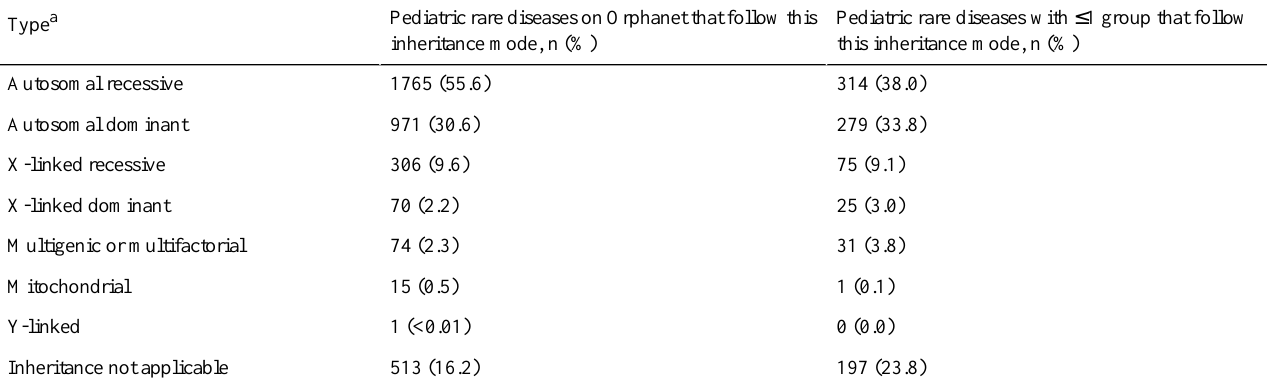
Table 2. Pediatric rare diseases on Orphanet and diseases with at least one group that follow the different inheritance modes (more than one may apply). (%)Pediatric rare diseases on Orphanet that follow this (%)Type inheritance mode, n